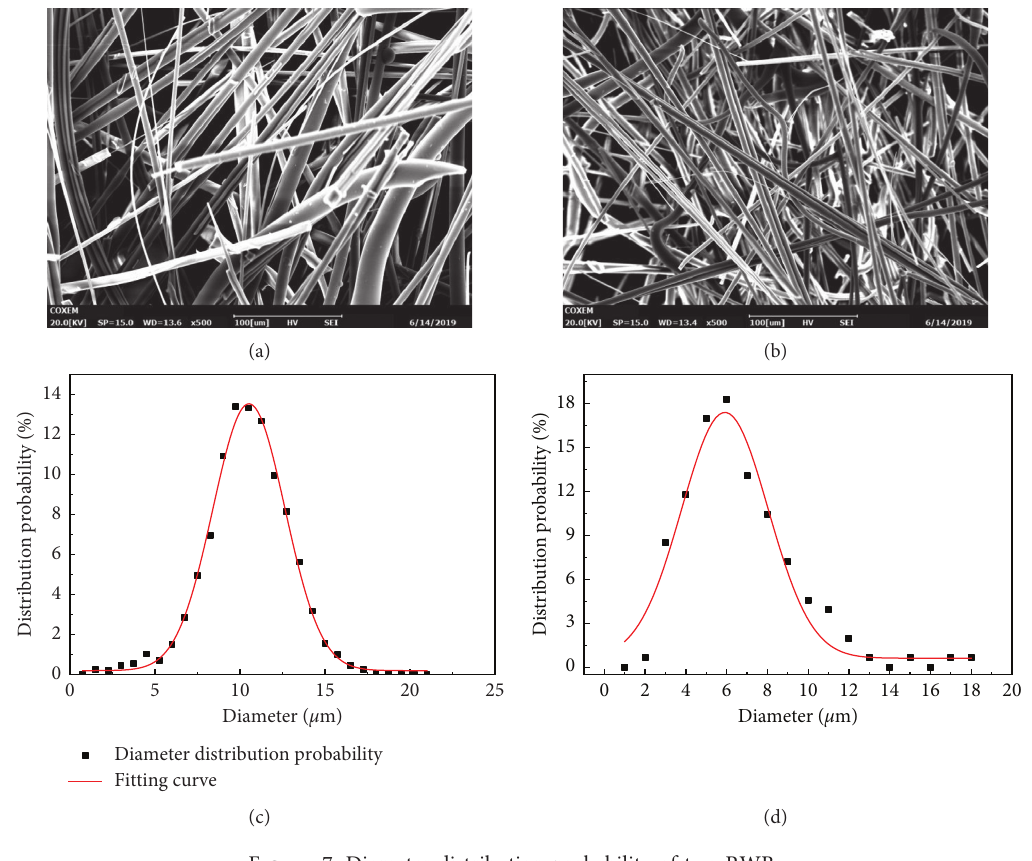
Figure 7: Diameter distribution probability of two RWBs.